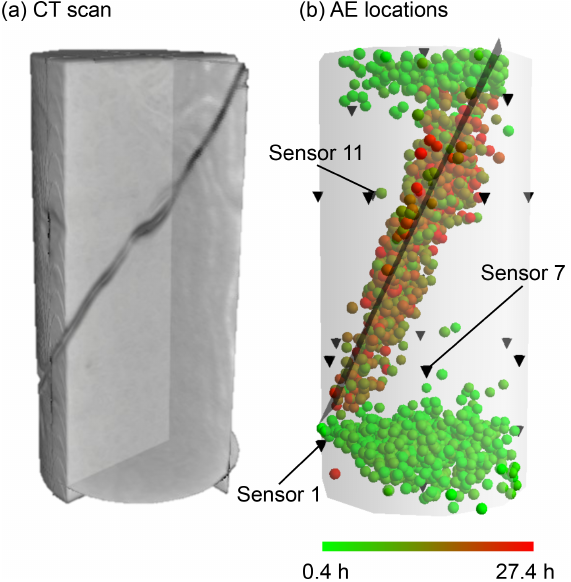
Figure 3. (a) X-ray computed tomography of the Red Wildmoor sandstone sample following testing. (b) 2342 located acoustic emis- sion (AE) events (coloured spheres) contained within the sample cylinder. Black upside-down cones show the locations of the AE re- ceivers (sensor 11 is located at the far side of the sample). The grey plane is a manual fit of the